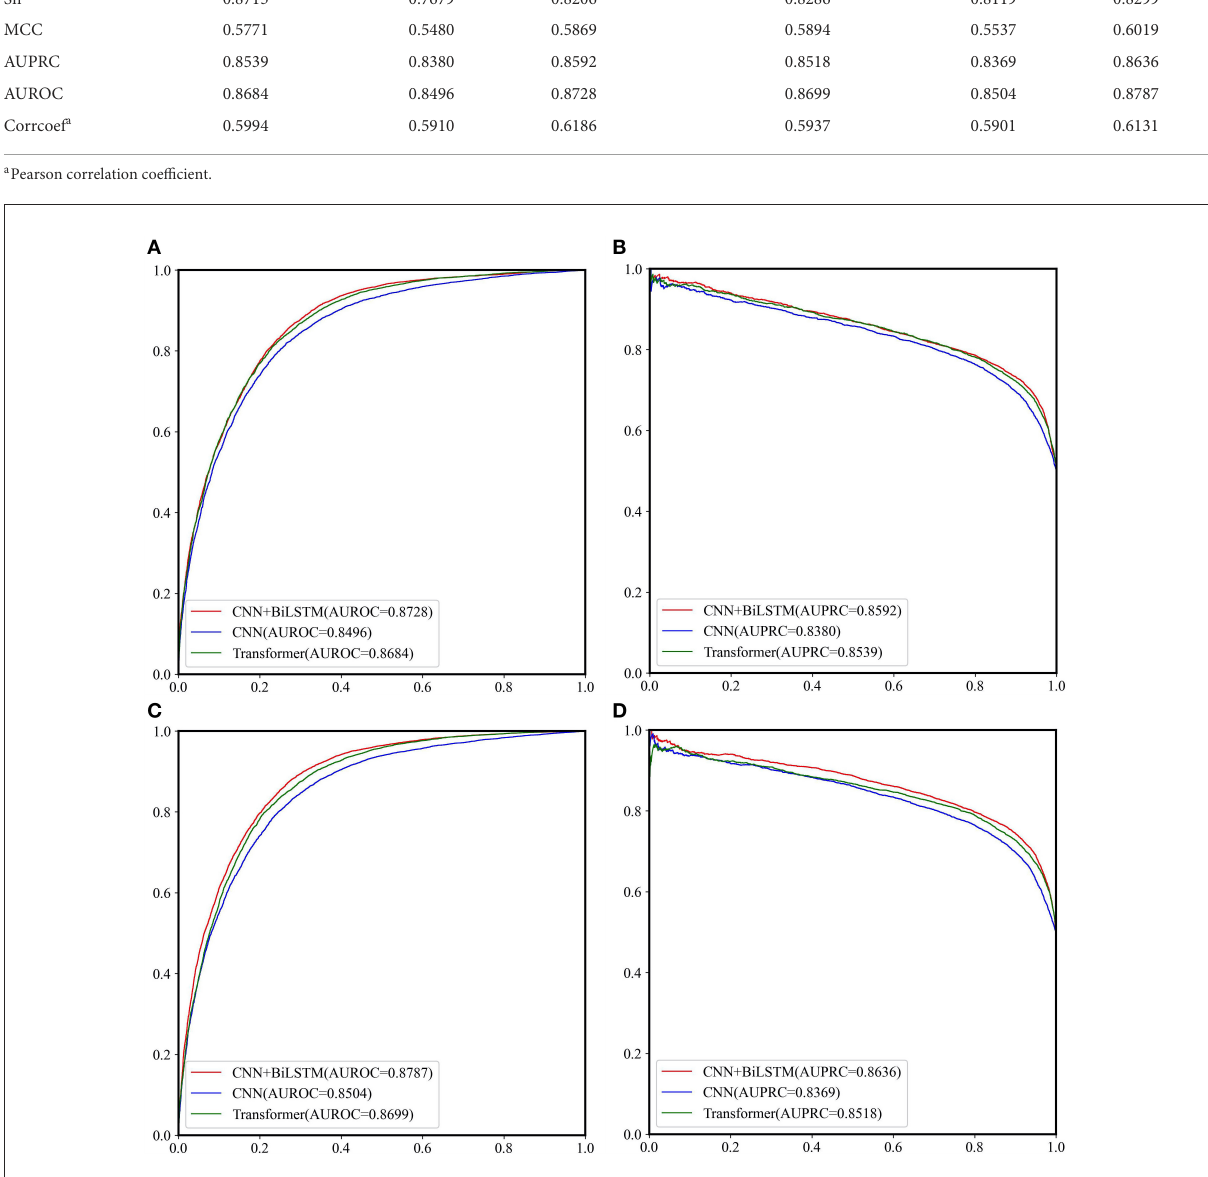
index, which can be used even when the category data is